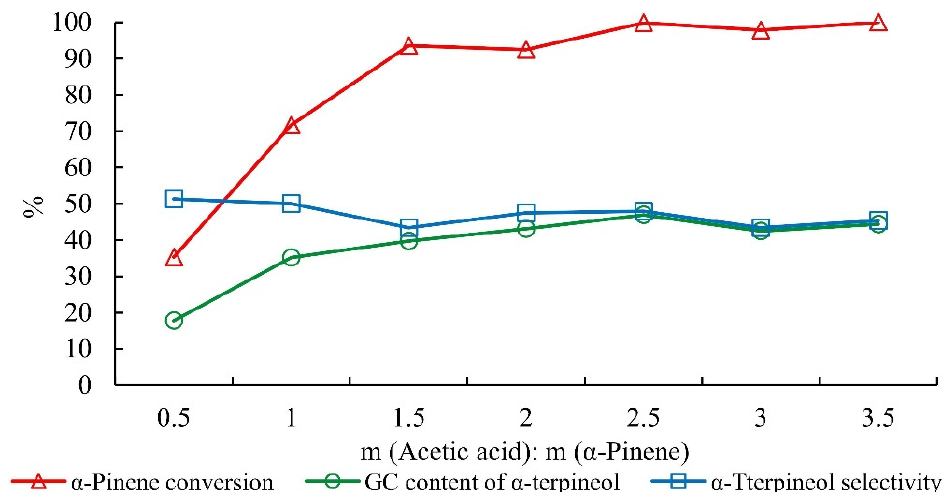
Figure 5. Effect of acetic acid dosage on the hydration of alpha-pinene. Note: The mass ratio of alpha-pinene, water, AHA, and phosphoric acid was 1:1:0.1:0.05 for 15 h.